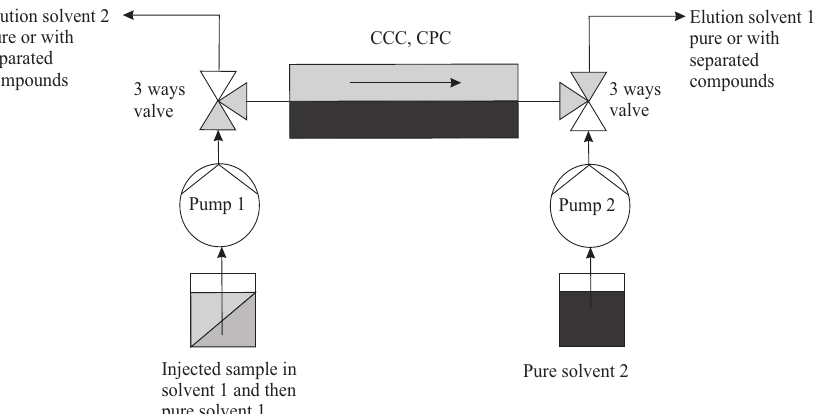
Figure 11. Typical topology of multiple dual mode (MDM). Here, the direction of elution with solvent 1 (light grey) is represented. In the following cycle, pump 2 can put in motion the second immiscible solvent 2 (dark grey). It is assumed here in the special case that an injection is made in solvent 1 (grey) and that the collection of separated solutes is done on the right in solvent